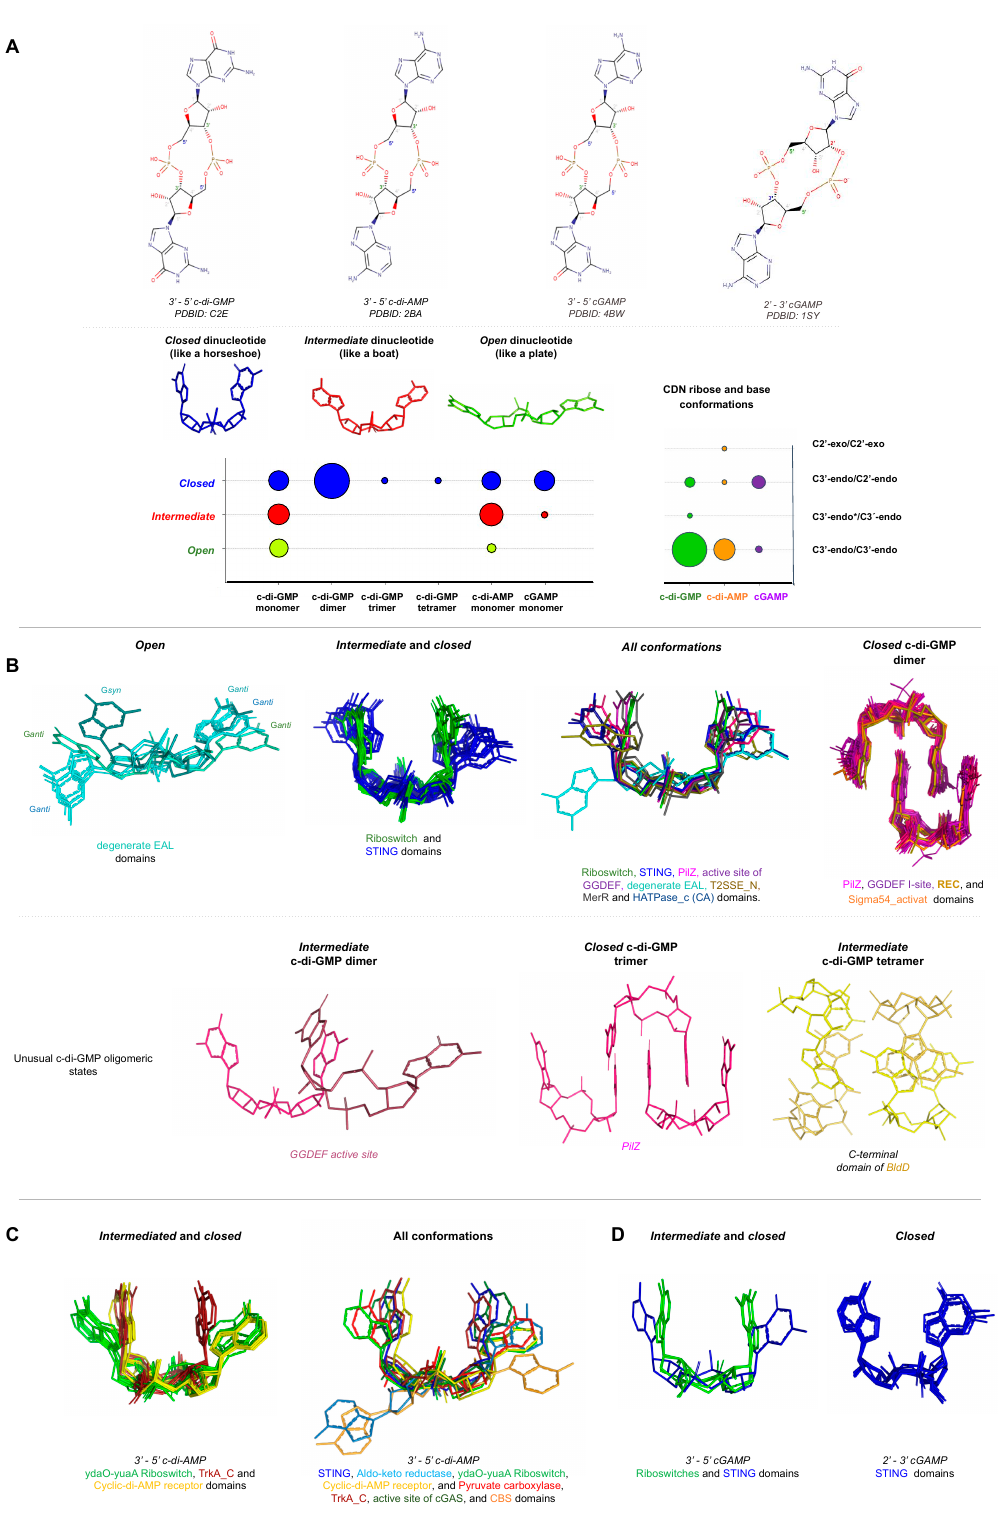
Figure 8. Diversity of cyclic dinucleotides produced by different organisms. All structures were observed within the three-dimensional protein structures deposited in the Protein Data Bank. ( A ) top panel: two-dimensional representation of different cyclic dinucleotides produced mainly by bacteria, with the exception of the 2’-3’ cGAMP molecule that is produced by eukaryotic cells by cGAS enzymes. The linkages between the pentoses and the phosphates are shown in green, blue, or red, and